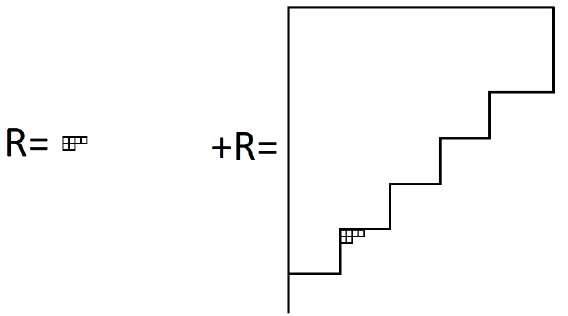
Figure 3 . To obtain + R from R we stack R at one of the inward pointing corners of B